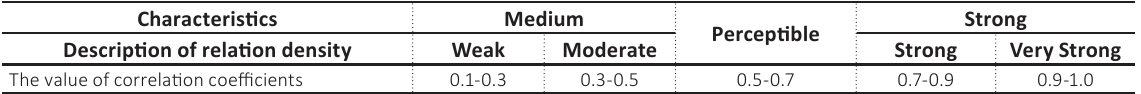
Source: Seleznyova et al.